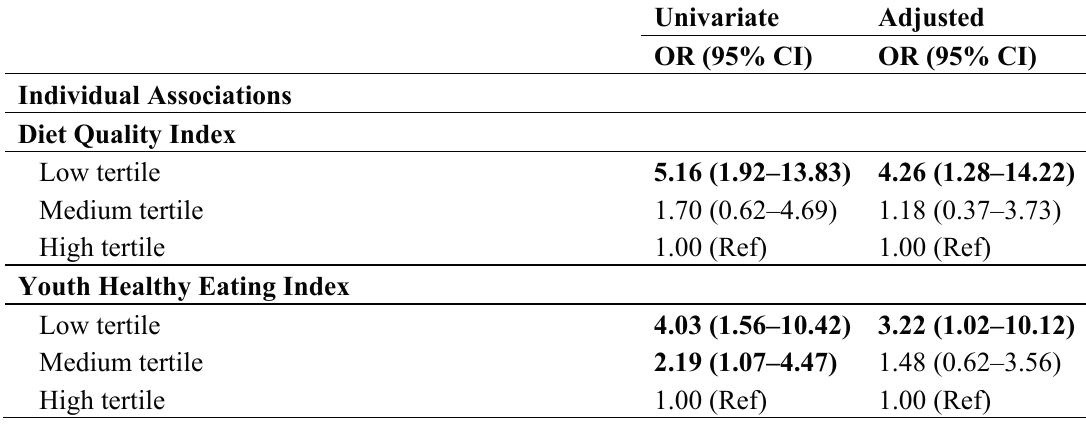
Table 2. Odds ratios (OR) and 95% confidence intervals (CI) for the association between health behaviours and poor academic performance in English Language Arts. Models were adjusted for household education and income, models with dietary exposures were further adjusted for energy